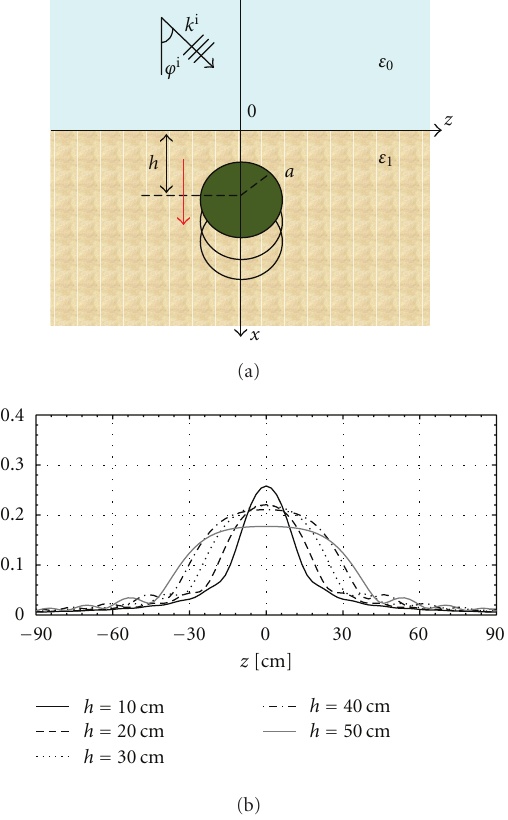
Figure 7: Total scattered field in air, along a line parallel to the interface, for di ff erent values of the burial